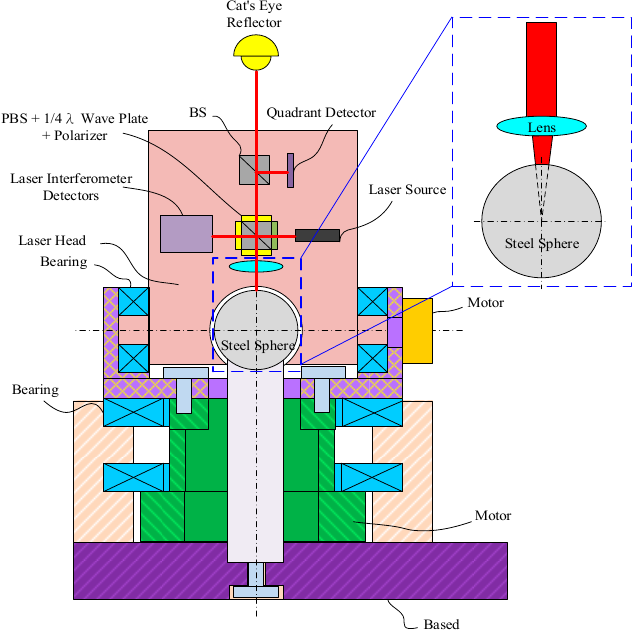
Figure 1. Illustration of the basic structure of LaserTRACER in which the reflected light is focused on the sphere center by the lens. (Note: BS = Beam Splitter; PBS = Polarizing Beam Splitter).